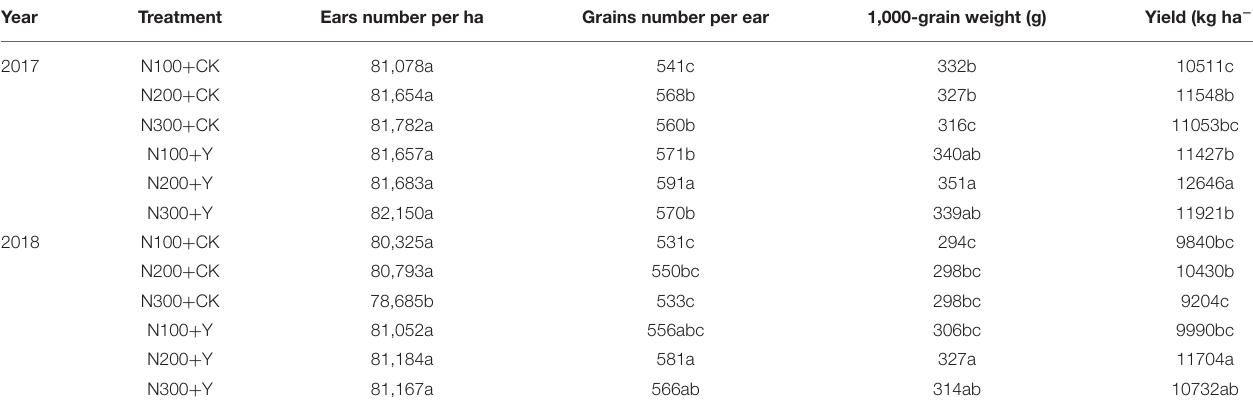
TABLE 8 | Effects of chemical control and nitrogen fertilizers on yield and yield components of maize during the maize growing period 2017 and 2018.